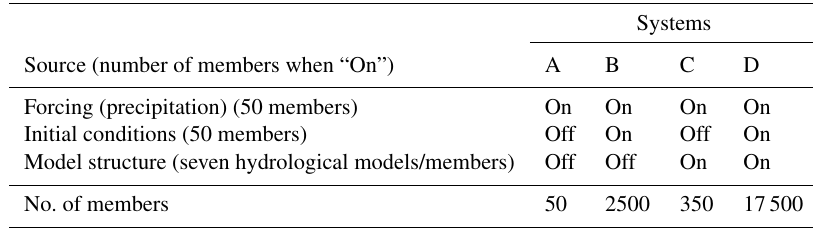
Table 1. Forecasting systems A, B, C, and D of the study and total number of members of the resulting ensemble streamflow forecast. On (off) indicates when uncertainty is (is not) quantified with the help of ensemble